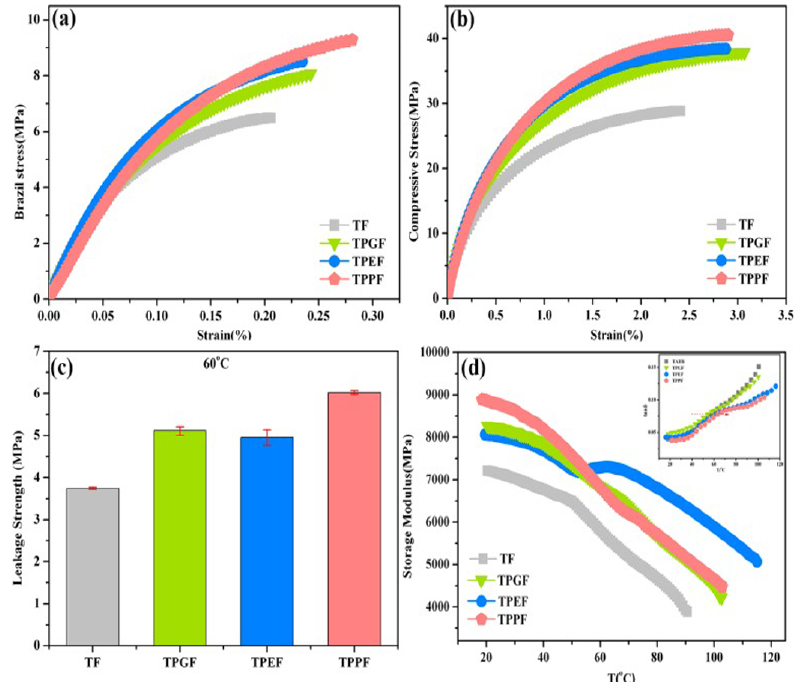
Figure 8. Stress–strain curves of ( a ) Brazil test, ( b ) compression test, ( c ) leakage strength, and ( d ) storage modulus for TATB-based polymer-bonded explosive (PBX) with and without grafting. (TF: TATB/F 2314 , TPGF: TATB@PDA@GAP/F 2314 , TPEF: TATB@PDA@PEG/F 2314 , TPPF: